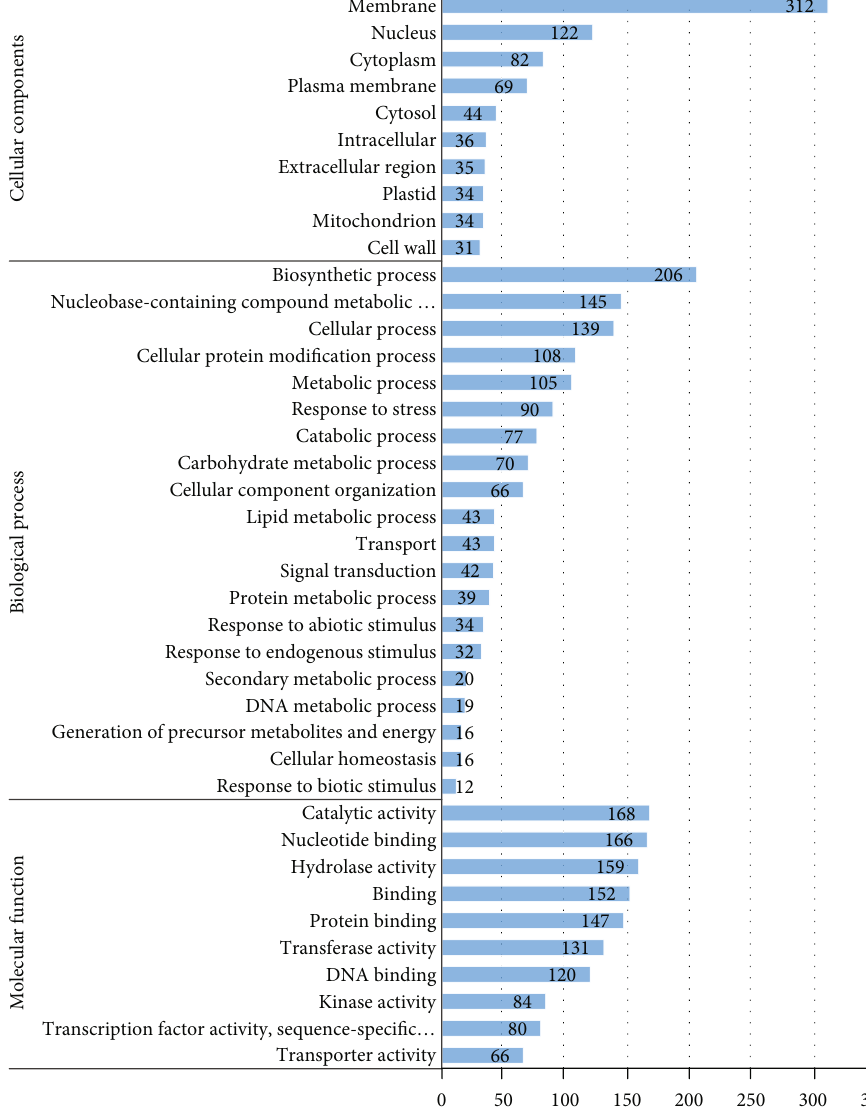
Figure 2: GO classi fi cation of the upregulated genes under heat